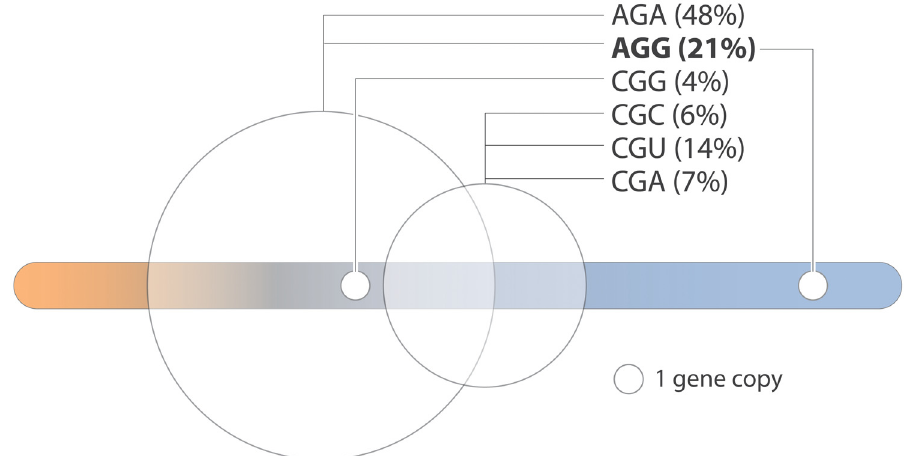
Fig 8. Yeast tRNA Arg and their decoding capacity. The figure describes the position on the affinity continuum for yArgRS as well as the arginine codons translated by the four tRNAs, Arg (UCU), (CCG), (ACG) and (CCU). A circle of proportional diameter represents the tRNA gene copy number. tRNA Arg (UCU) and (CCU) both translate AGG